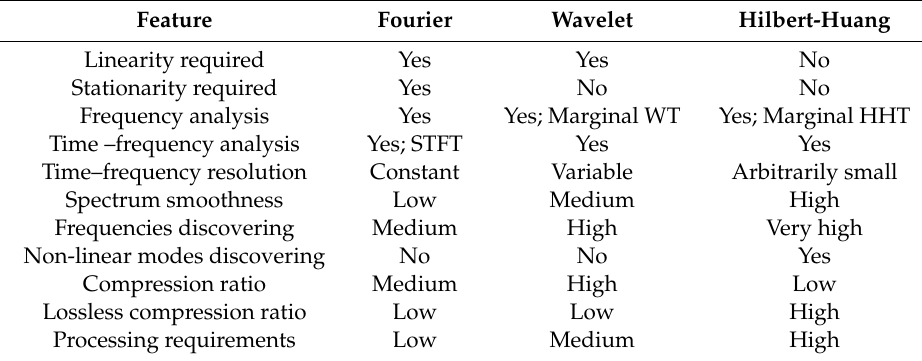
Table 2. Comparison of spectral analysis techniques.